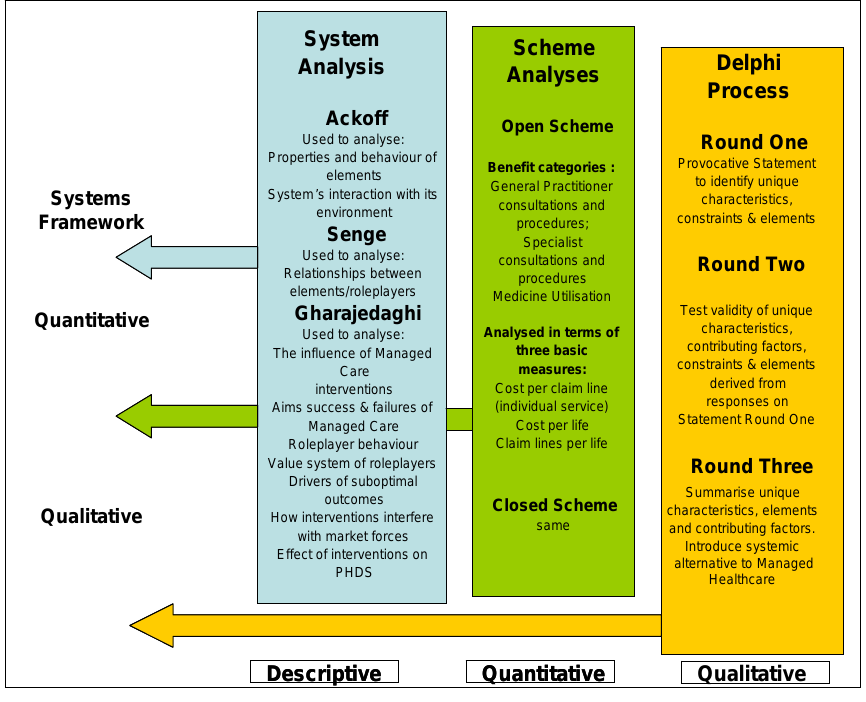
Figure 4: Research